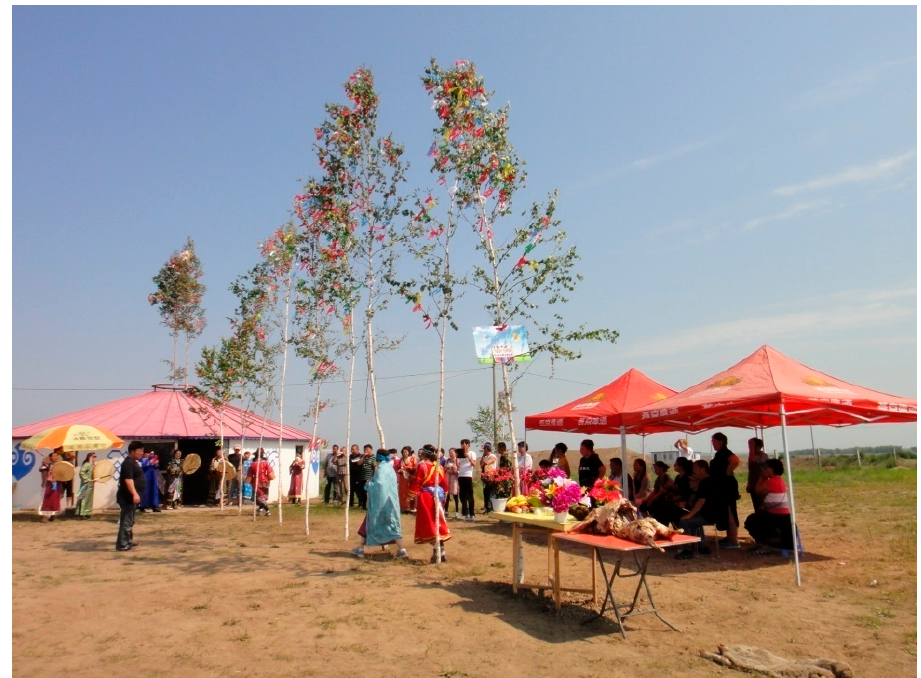
jad’ ə n and bar ʃ ). Photo: Minna Sa, 2013.